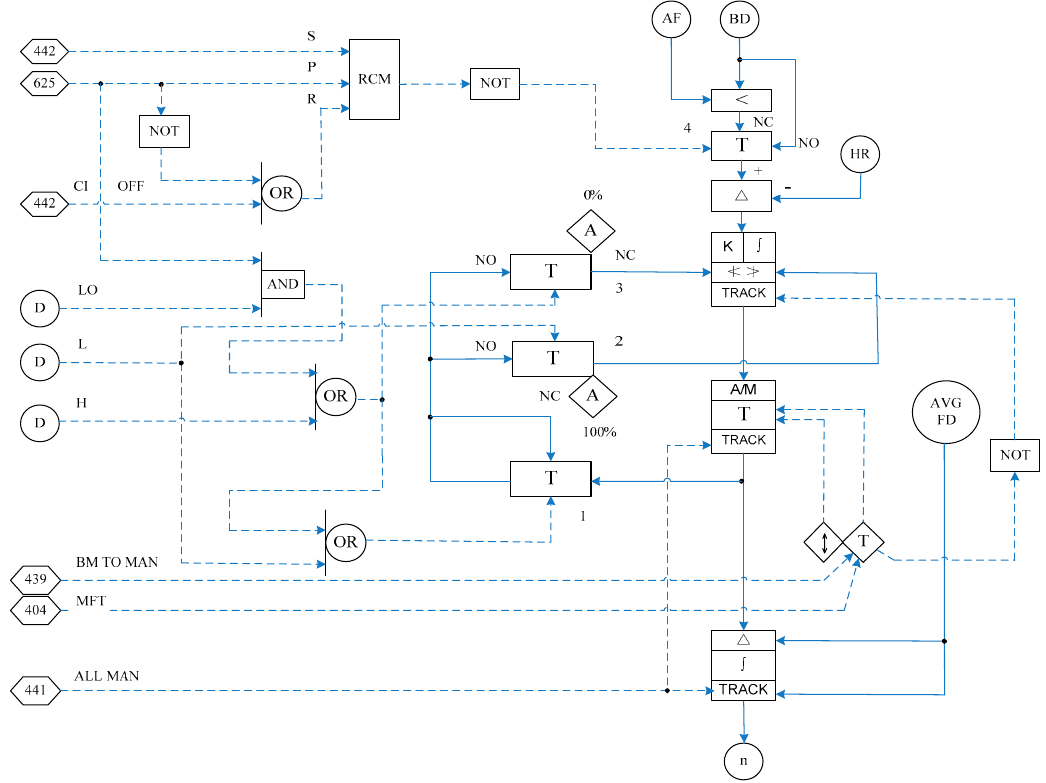
Figure 31. The Scientific Apparatus Makers Association (SAMA) diagram of the fuel quantity control system .